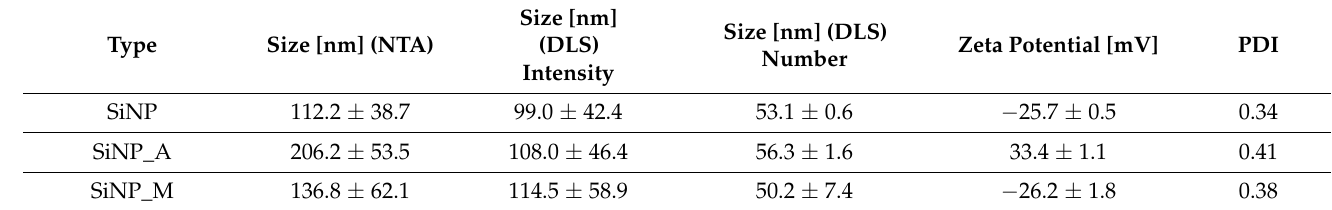
Table 1. Physicochemical properties of SiNP, SiNP_A and SiNP_M. Size (NTA): Average ± SD of the hydrodynamic diameter mode values of five measurements. Size (DLS): Average ± SD of mean values from intensity- and number-weighted distribution analyses of three measurements. Zeta po- tential: average ± SD in mV determined when resuspended in buffer (HEPES). PDI: Polydispersity index ranging from 0 (perfectly uniform sample with respect to particle size) to 1 (highly polydis- perse sample with multiple particle size populations).